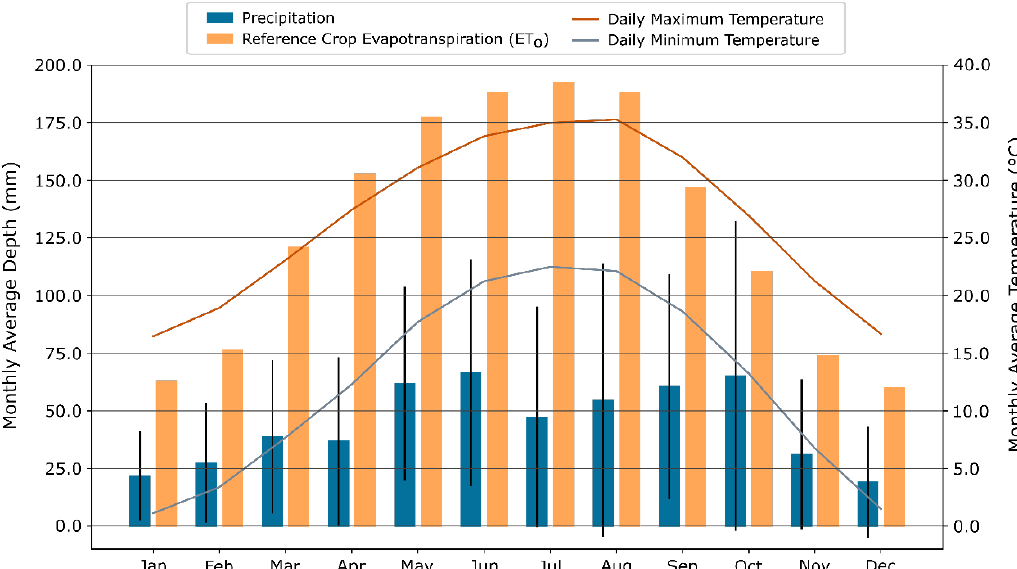
Figure 2. Site Watershed 1981–2010 Climate Normals from PRISM with Historical Average ET o . Daily temperature and precipitation depth values come from PRISM, and Climate Normals were calculated from daily watershed values. Error bars shown on precipitation depth columns are plus and minus one standard deviation. Historic average monthly ET o depth was obtained from the Texas A&M Agrilife Extension [30] for Del Rio, Texas which is south of the study site. ET o is the potential evapotranspiration for a reference crop, typically a short grass. For average conditions, excess evaporative capacity exists for every month of the year.